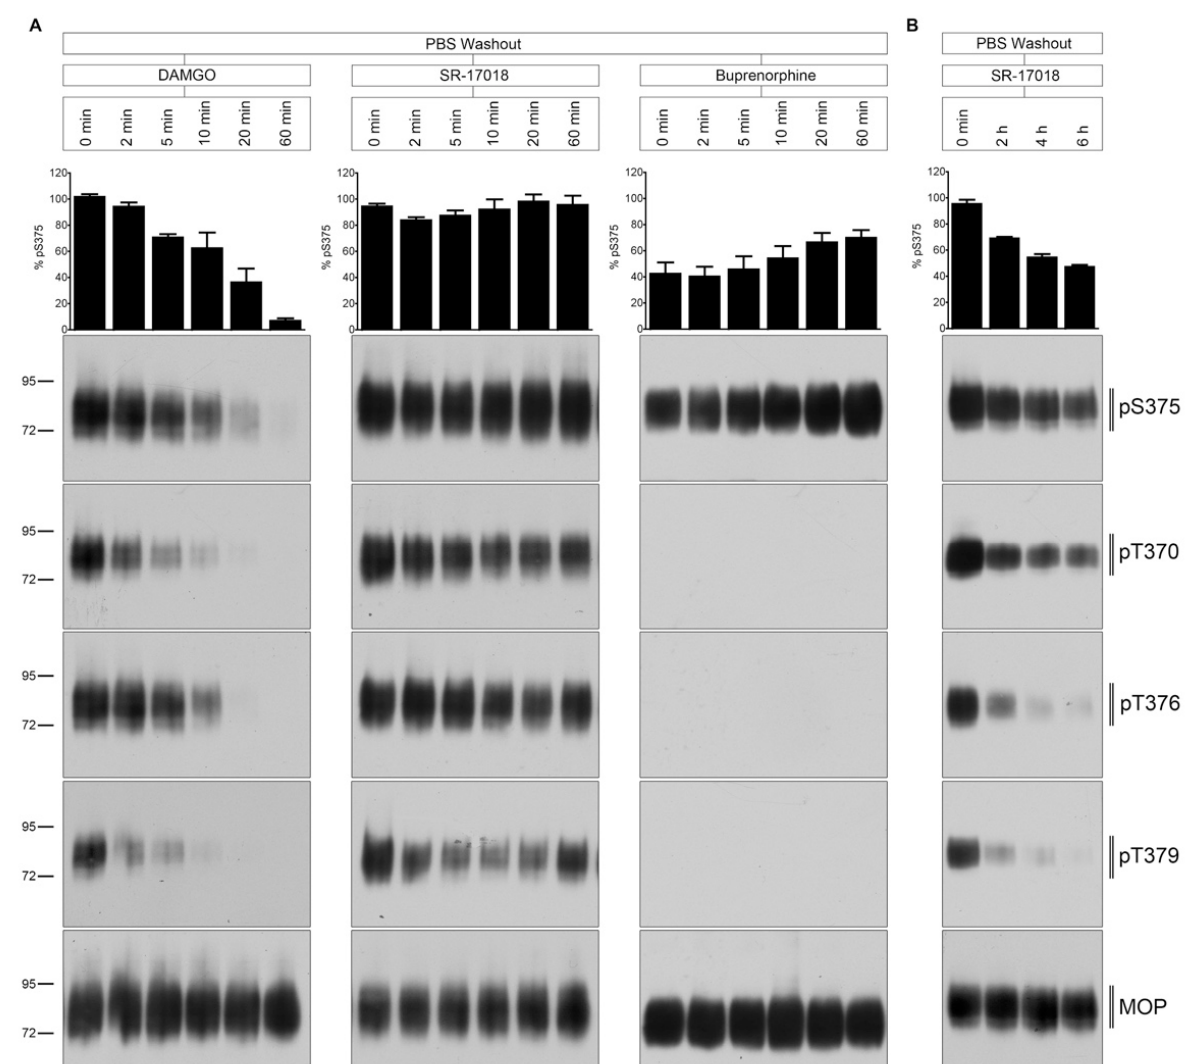
Figure 4. Time course of multisite dephosphorylation after PBS buffer washout. ( A ) HEK293 cells stably expressing HA-MOP were incubated with (left panel) 10 µM DAMGO, (middle panel) 10 µM SR-17018, or (right panel) buprenorphine for 30 min at 37 °C. Cells were washed three times with PBS buffer (PBS washout) and then incubated in the absence of agonist for 0, 2, 5, 10, 20, or 60 min at 37 °C. ( B ) HEK293 cells stably expressing HA-MOP were incubated with 10 µM SR-17018 for 30 min. Cells were washed three times with PBS buffer and then incubated in the absence of agonist for 0, 2, 4, or 6 h at 37 °C. ( A , B ) Cells were lysed and immunoblotted with the anti-pT370 (pT370), anti-pT376 (pT376), anti-pT379 (pT379), or anti-pSer375 (pS375) antibodies. Blots were stripped and reprobed with the phosphorylation-independent anti-HA-tag antibody to confirm equal loading of the gels (MOP). S375 phosphorylation was quantified (upper panel) and expressed as percentage of maximal phosphorylation in control cells, which was set at 100% (data not shown). Data correspond to mean ± SEM from three independent experiments. Positions of molecular mass markers are indicated on the left (in kDa). Blots are representative of three independent experiments.